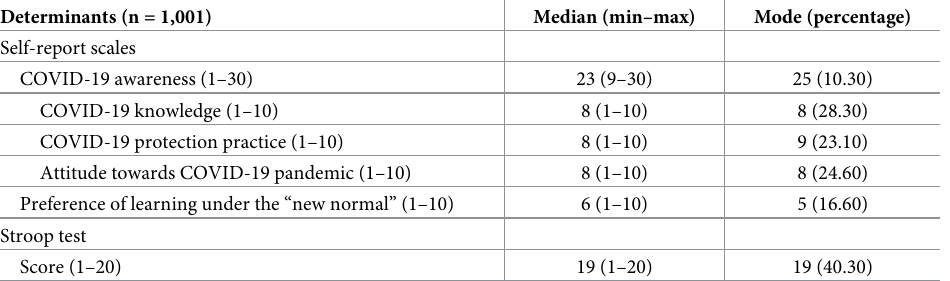
Table 2. Self-report scales for COVID-19 awareness and preference of learning under the “new normal”, and the Stroop test score of the Thai health professional students. Determinants (n = 1,001) Median (min–max) Mode (percentage) Self-report